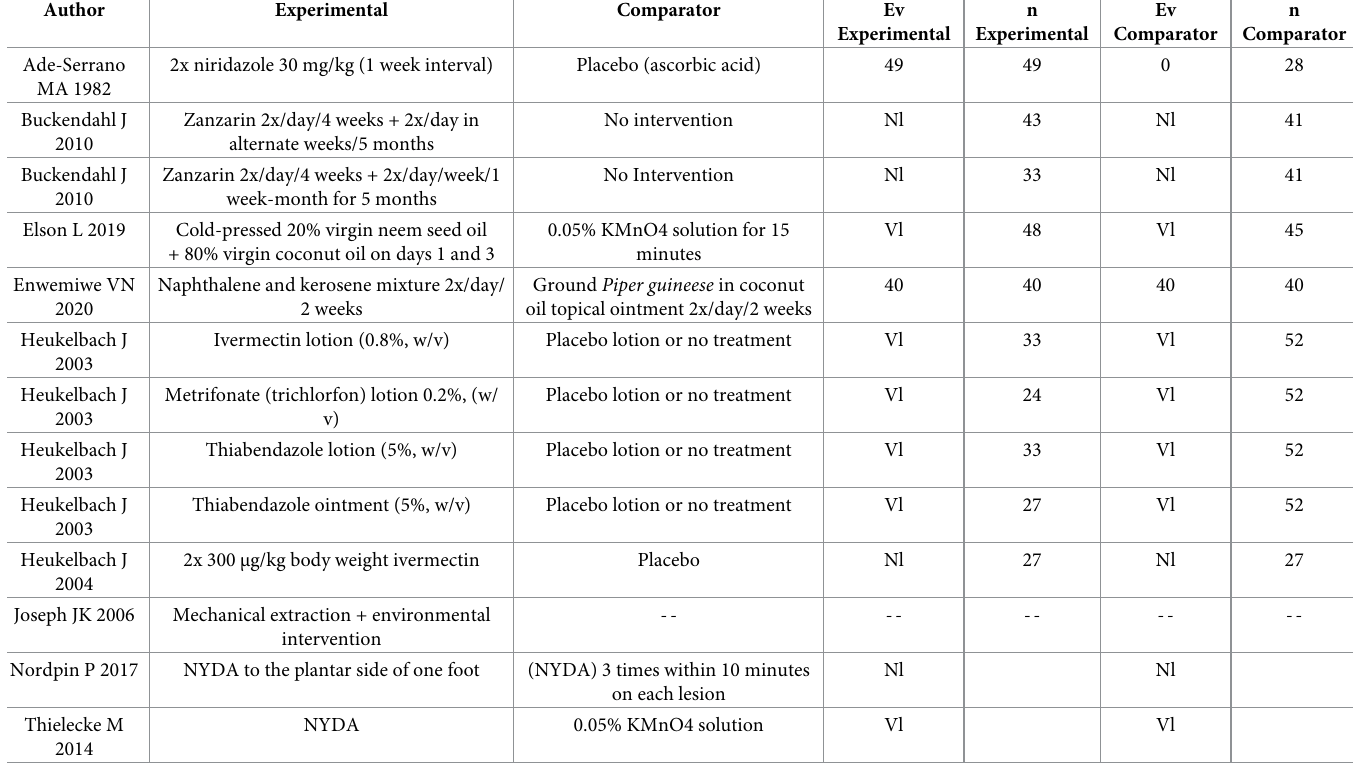
efficacy.[17,18] An additional study tested the effect of mechanical extraction in addition to environmental interventions on the control of tungiasis, calling attention to this important technique for the control of the disease. Unfortunately, the detailed data of each individual were not reported.[16]. Table 3. Details of the interventions evaluated in the 8 included clinical trials. Different comparisons within the same study were considered different levels of analysis and are included in different